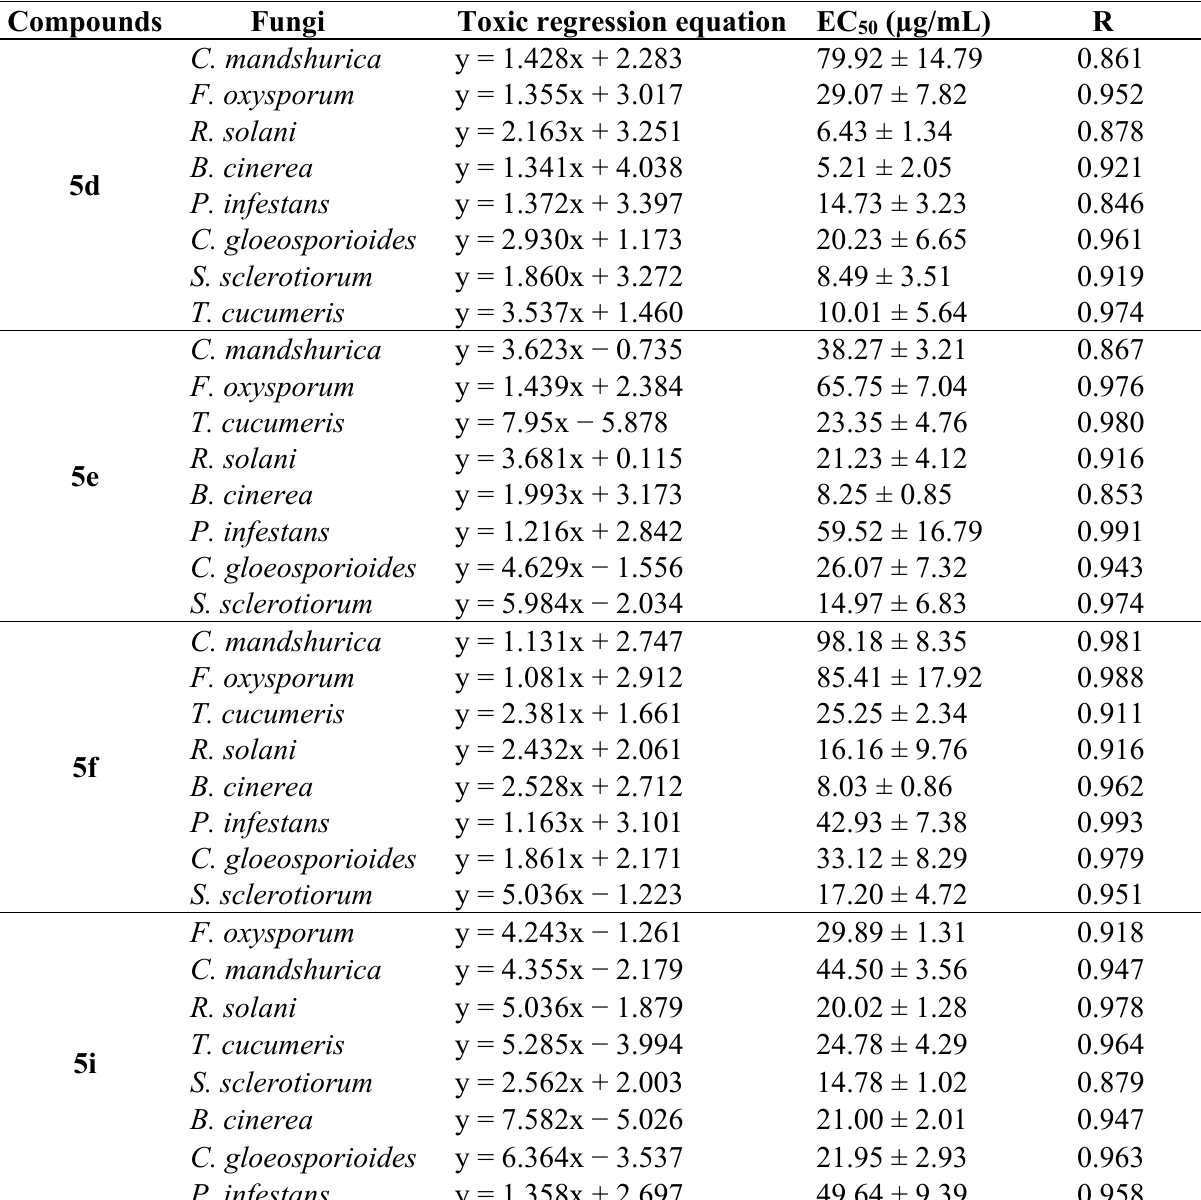
Table 2. Toxicity of some methyl sulfones on eight kinds of pathogenic